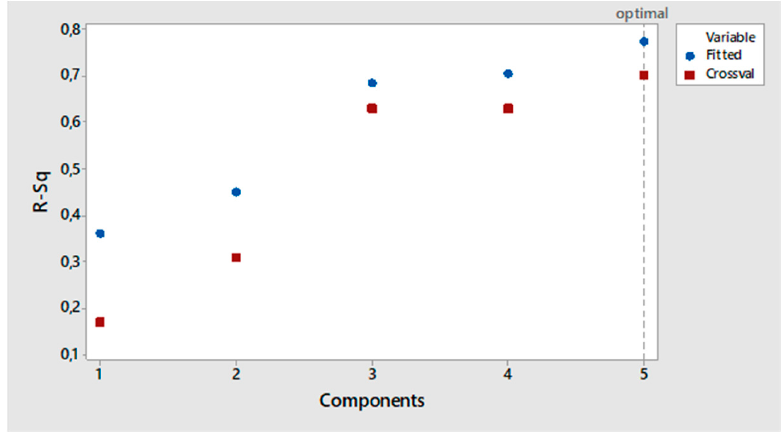
Figure 2. PLS model selection plot—q u max .